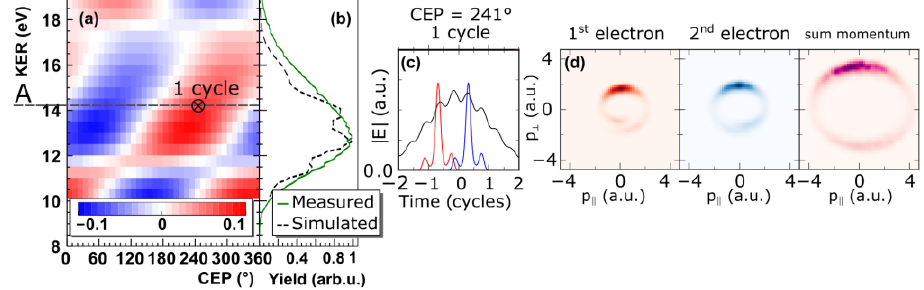
Fig. 2. (a): Measured polarization-frame asymmetry of two-electron emission calculated as the normalized difference between the ionization yields where both electrons are emitted into either the upper or lower hemisphere. The line marks the KER value corresponding to an ionization delay of 1 cycle. (b): Yield of double ionization as a function of KER (measured and simulated). For the point of maximum asymmetry marked in (a) we show the simulated ionization probabilities in (c) for first (red) and second (blue) electron on top of the magnitude of the electric field (black line). The 2D momentum distributions of first and second electron in polarization plane as well as the distribution of the sum momentum are given in